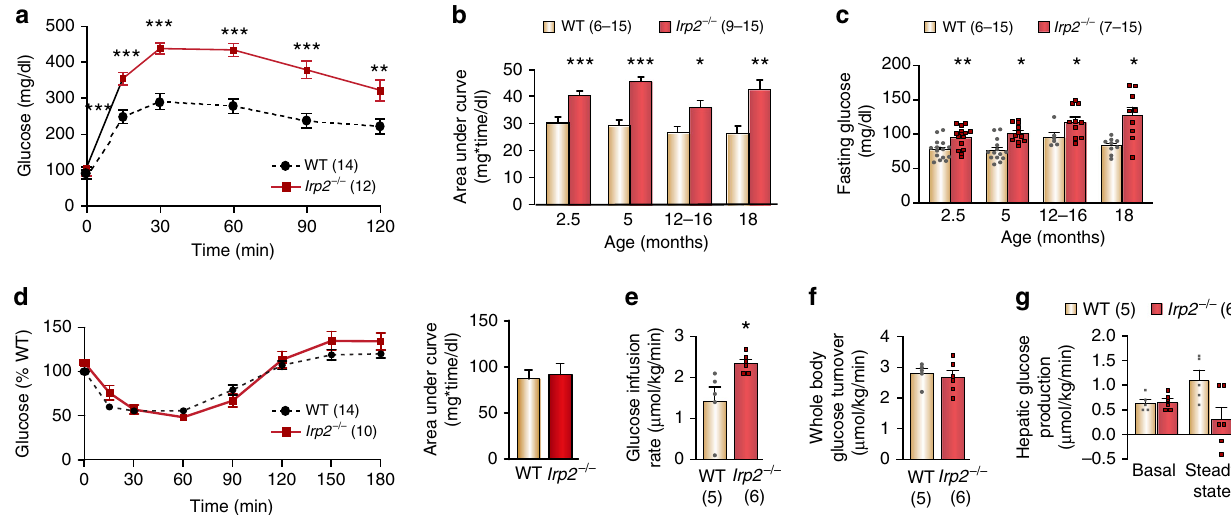
Fig. 1 Glucose intolerance in Irp2 − / − mice is not caused by impaired peripheral and hepatic insulin action. a Intraperitoneal glucose tolerance tests (ipGTTs) for 5-month-old WT and Irp2 − / − mice (2 g glucose/kg body weight). b Glucose AUC calculated from ipGTTs for WT and Irp2 − / − mice at the indicated ages. c Plasma glucose concentrations for fasted WT and Irp2 − / − mice. d Insulin tolerance tests (ITTs) performed in random-fed 5-month-old WT and Irp2 − / − mice. Glucose AUC graph is shown on the right. e – g Euglycemic-hyperinsulinemic clamp experiments conducted in fasted 7-month-old WT and Irp2 − / − mice. Glucose infusion rate ( e ), whole-body glucose turnover rate ( f ), and hepatic glucose production ( g ). Data in a – g are expressed as means ± s.e.m., unpaired two-tailed Student ’ s t test, * p < 0.05, ** p < 0.01, *** p < 0.001 relative to WT mice. The number of mice is indicated in parentheses. Source data are provided as a Source Data fi two insulin genes, Ins1 and Ins2 , were similar to WT islets (Fig. 3e). Morphometric quanti fi cation of insulin-stained paraf- fi n-embedded pancreatic sections showed that islet area and β -cell mass in 2.5- and 7.5-month-old Irp2 − / − mice were similar to age- matched WT mice, although islet area and β -cell mass tended to be reduced in 18-month-old Irp2 − / − mice (Fig. 3f, g; Supple- mentary Fig. 3a – d). Insulin, glucagon, and the glucose transporter Glut2 immunostaining displayed normal subcellular localization,